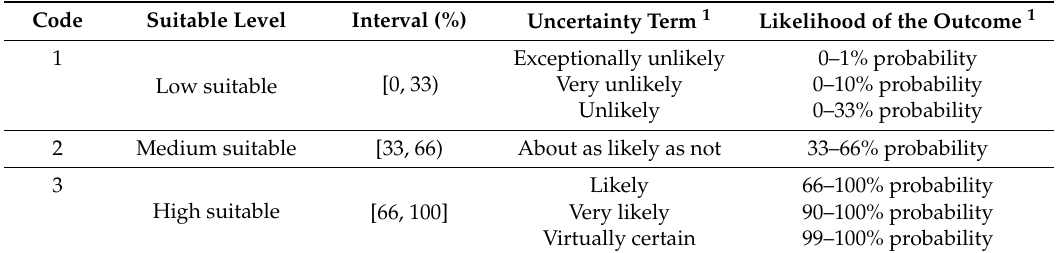
Table 2. Classification of the predicted changes of environmental